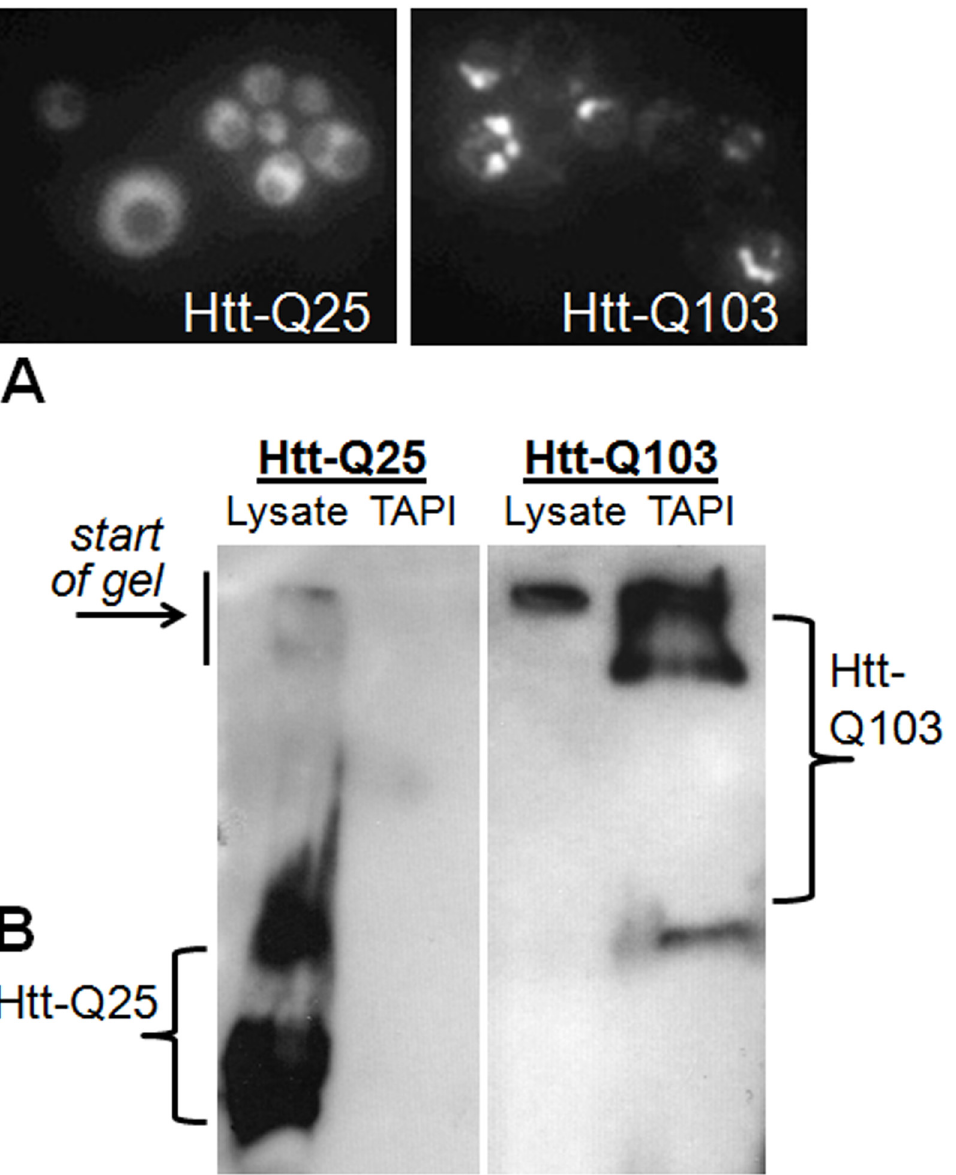
Fig 1. Polyglutamine-expanded Huntingtin exon 1 forms aggregates in yeast that can be isolated by TAPI. (A) Fluorescence microscopy of yeast expressing GFP-tagged Huntingtin exon 1 (Htt) with a normal (Q25) or an expanded polyglutamine tract (Q103). (B) Western blot of GFP-Htt-Q25 and GFP-Htt-Q103 showing that high molecular weight aggregates can be isolated from Htt-Q103 expressing yeast cells. Lysate = input; TAPI = purified aggregate.